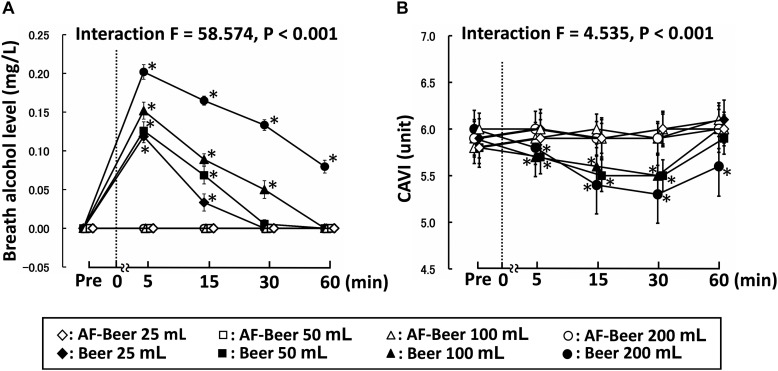
Effects of ingesting different doses of beer on alcohol level (A) and CAVI (B). Broken lines: time point of beverage ingestion; Pre: baseline; AF-Beer: alcohol-free beer ingestion; CAVI: cardio-ankle vascular index; *p < 0.05 vs. each pre; data are expressed as mean ± SE.